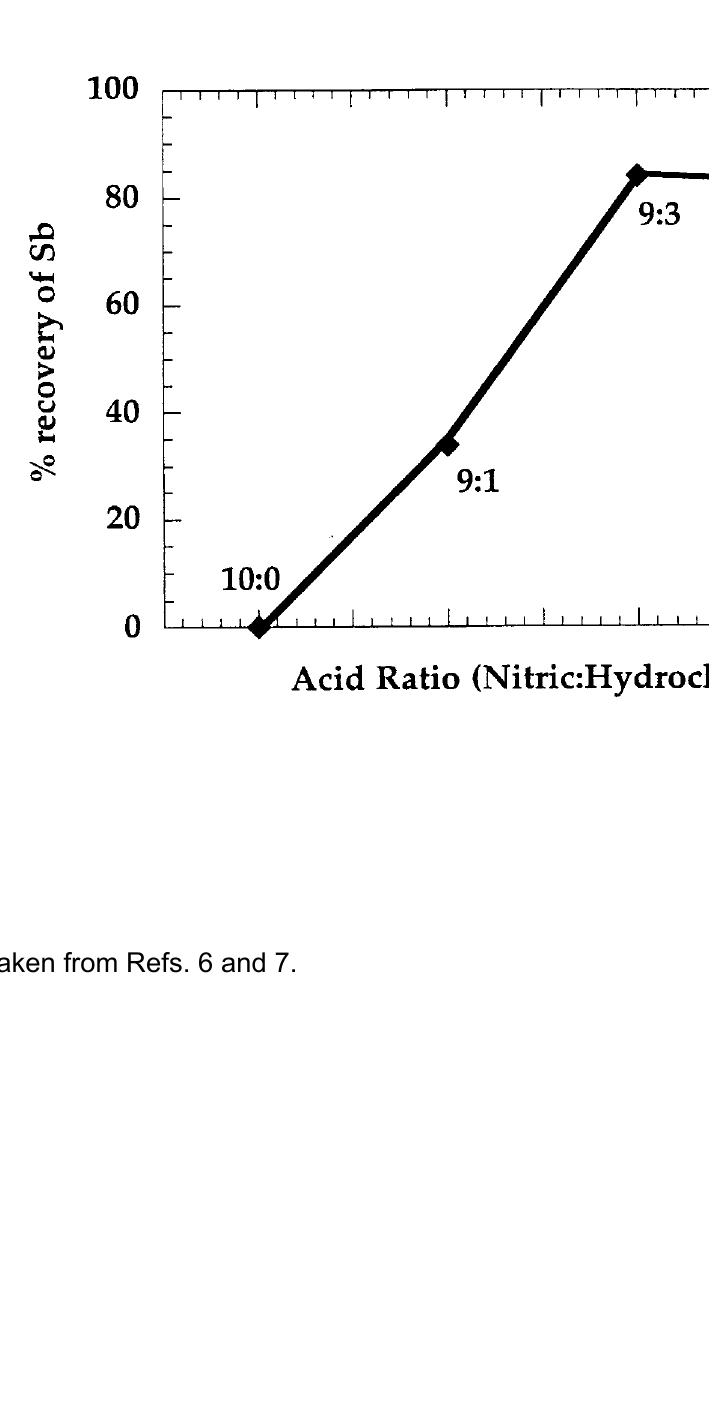
PERCENT RECOVERY OF ANTIMONY FROM NIST SRM 2704 (BUFFALO RIVER SEDIMENT) VERSUS VARIOUS COMBINATIONS OF NITRIC AND HYDROCHLORIC ACIDS(N=6)